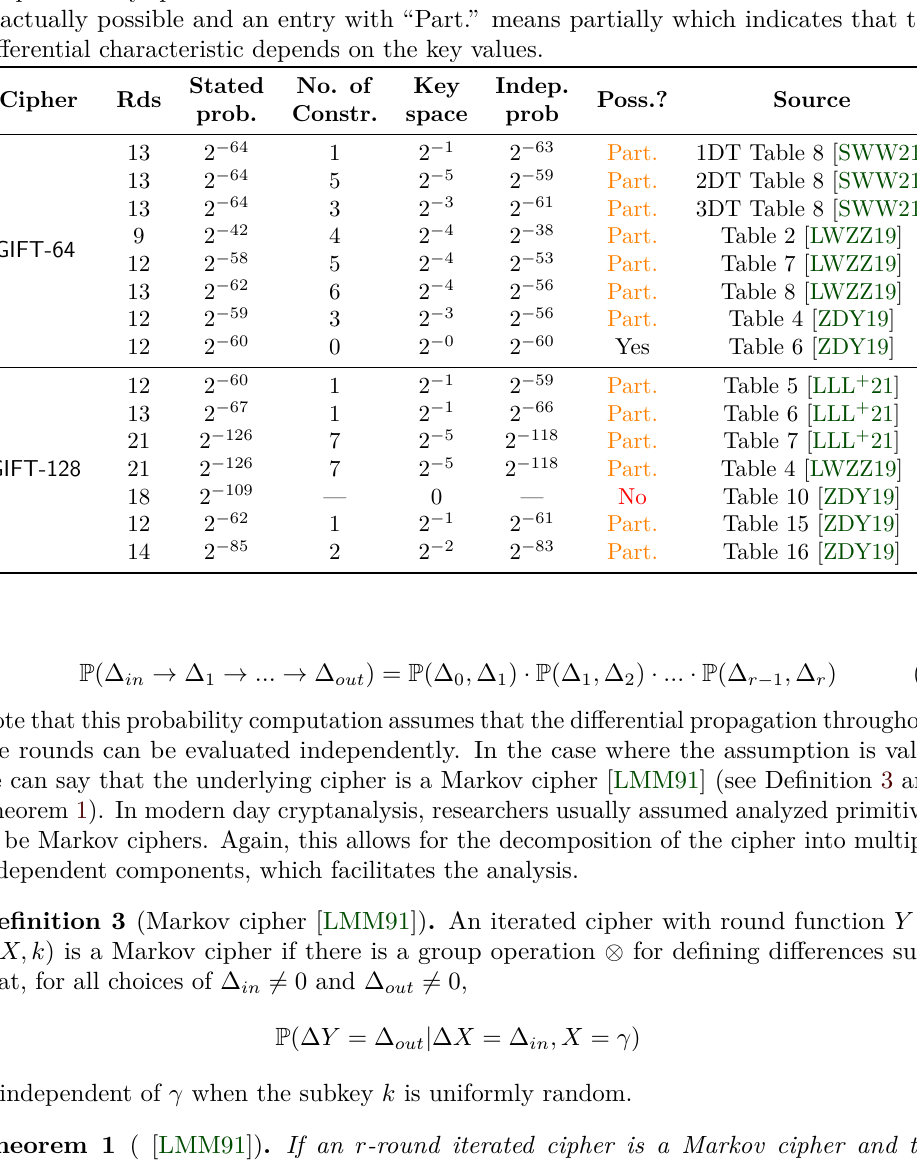
Table 3: The analysis of GIFT differential characteristics. “Stated prob” refers to the probability given by their respective authors. “Key space” refers to our estimation of the proportion of the total number of keys for which the differential characteristic can